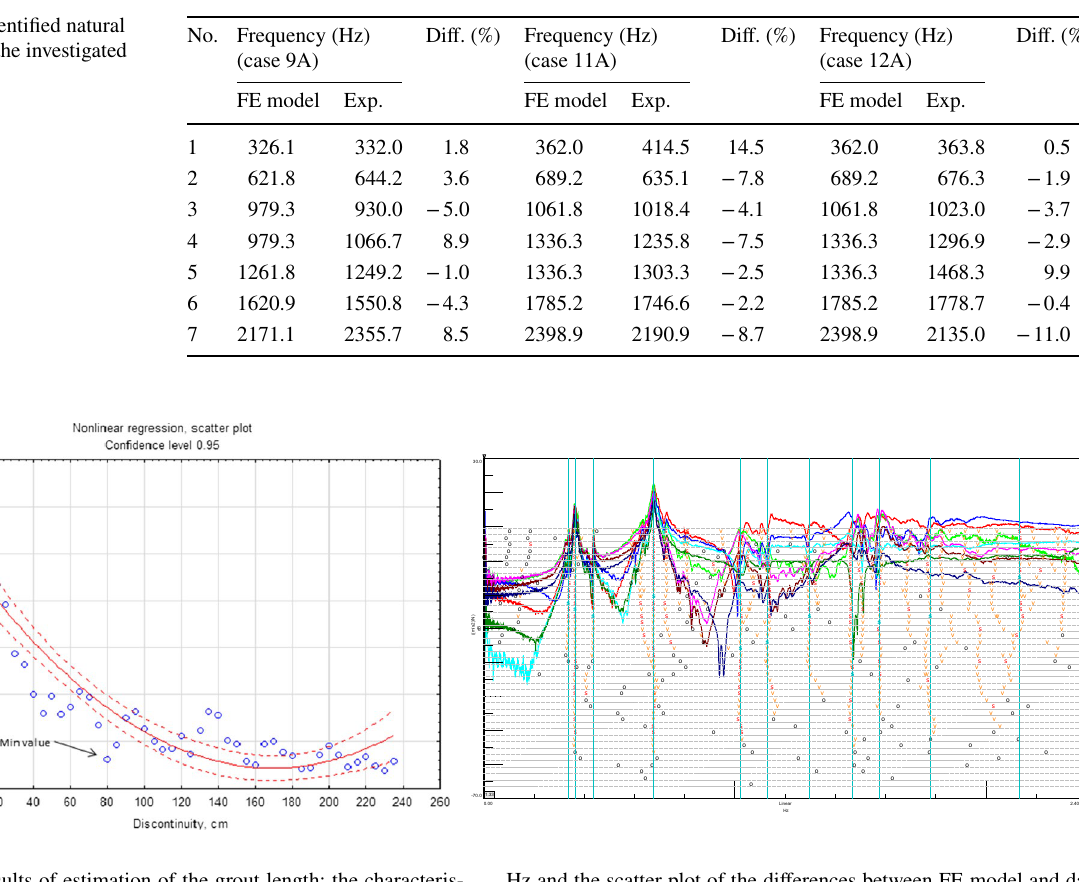
Hz and the scatter plot of the differences between FE model and data evaluated experimentally (min value for 0.80 m)